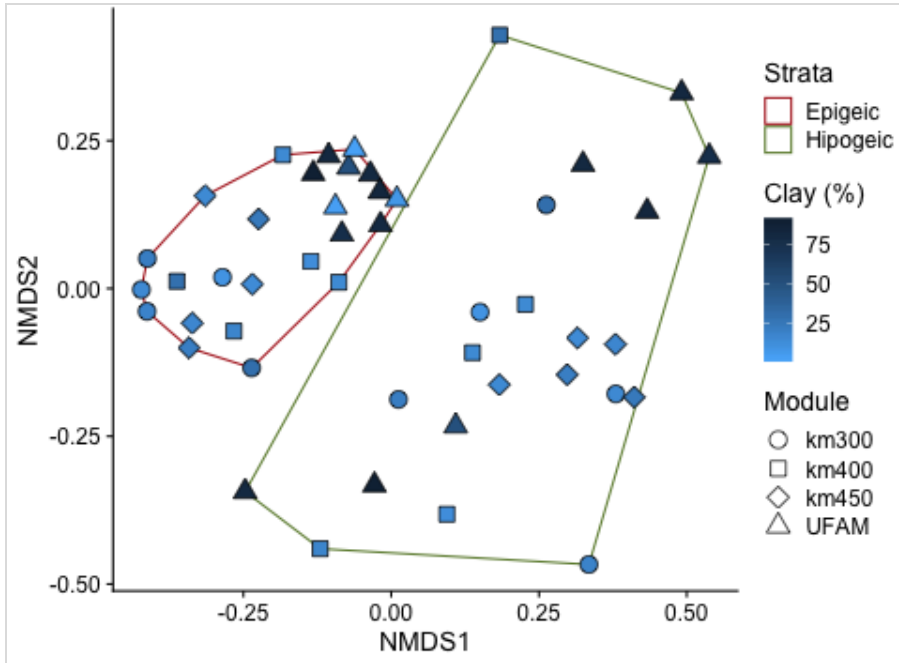
Fig 4. An NMDS ordination (Stress = 0.151) plot indicating the congruence in ant assemblages associations among sudied sites and the sampling strata in 47, 250-m long plots in ombrophilous forests in the Brazilian Amazon. Polygons delimit the epigeic and hypogeic strata and the color variation represents the clay